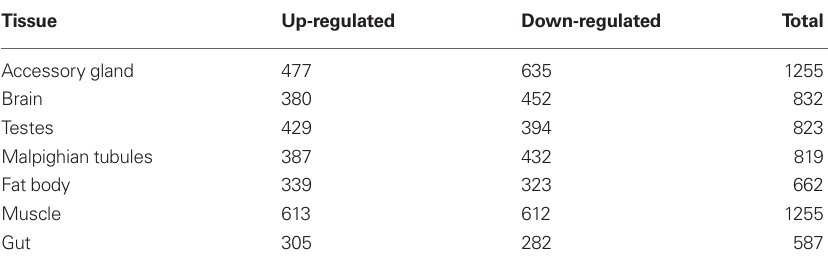
Table 1 | Up- and down-regulated genes with age in various tissues of D. melanogaster.